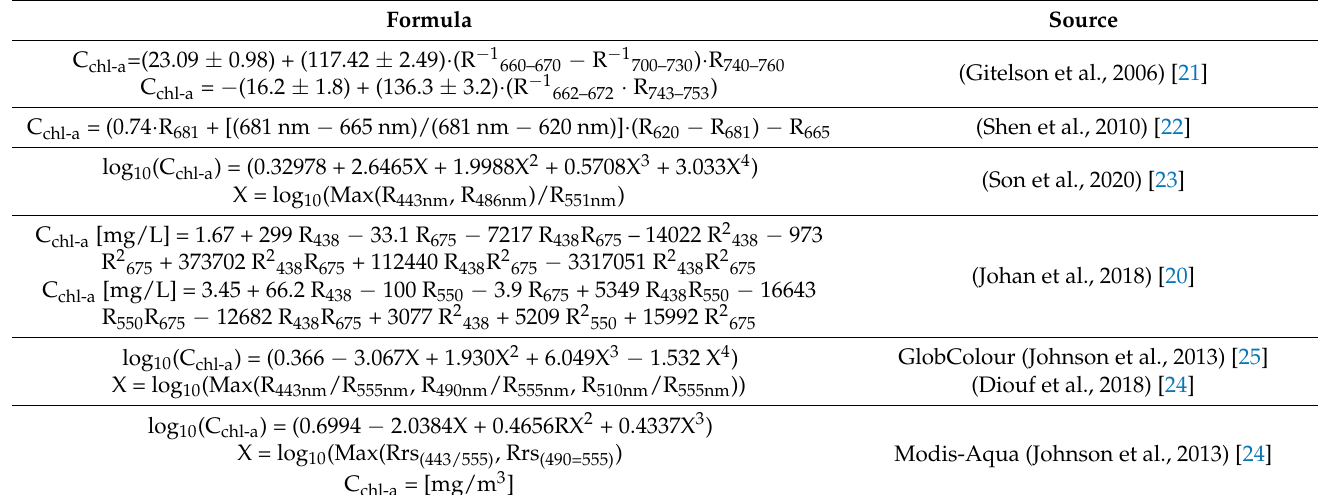
Table 1. Typical mathematical formulas to calculate chlorophyll a